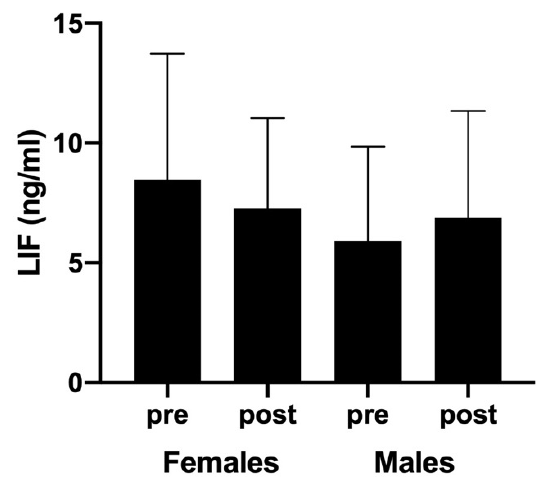
Figure 3. Blood LIF levels (ng/mL) measured before and after padel competition.